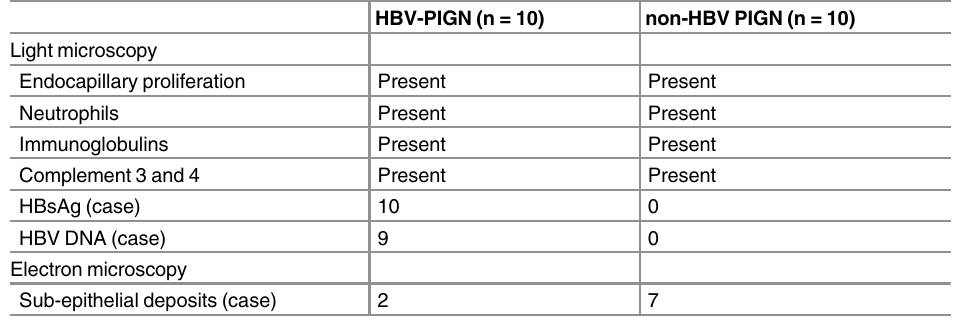
Table 2. Glomerular pathology.